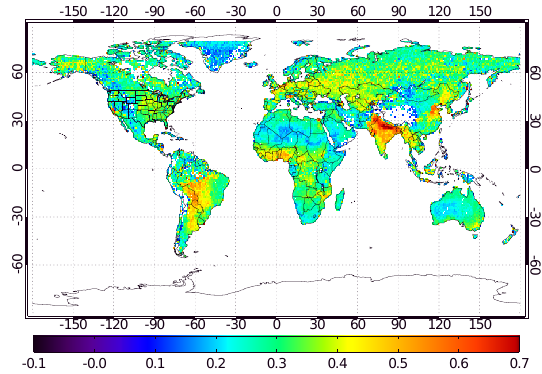
Figure 5. AIRS NH 3 DOFS values averaged over September 2002– August 2015 period. Red/blue colors indicate relatively high/low DOFS,